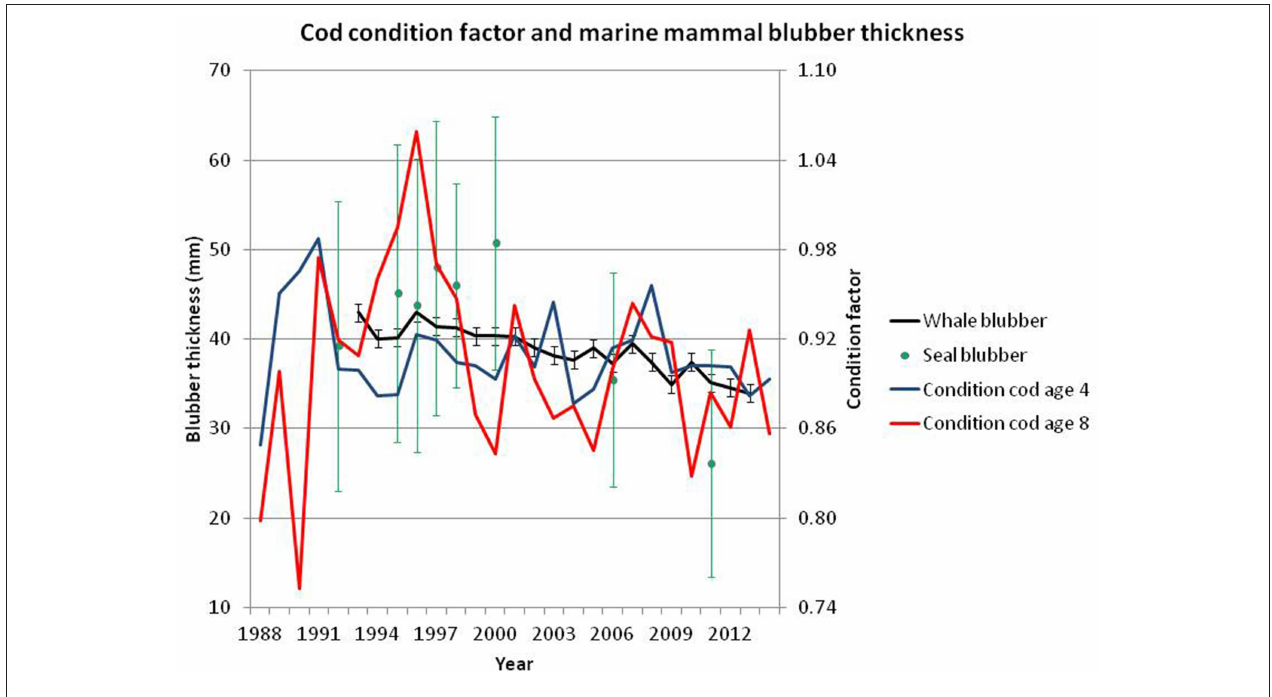
FIGURE 14 | Blubber thickness (mm, with 5–95% confidence intervals) for harp seal and minke whale (left axis) and condition factor (100000 × weight (kg)/L 3 (cm)) (right axis) for age 4 and 8 cod. Range of annual sample sizes (individuals measured): Harp seals